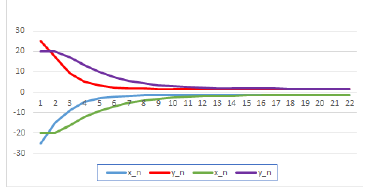
Figure 2. Convergence of parallel Mann iterative method (3.13) and parallel S -iterative method (3.14).